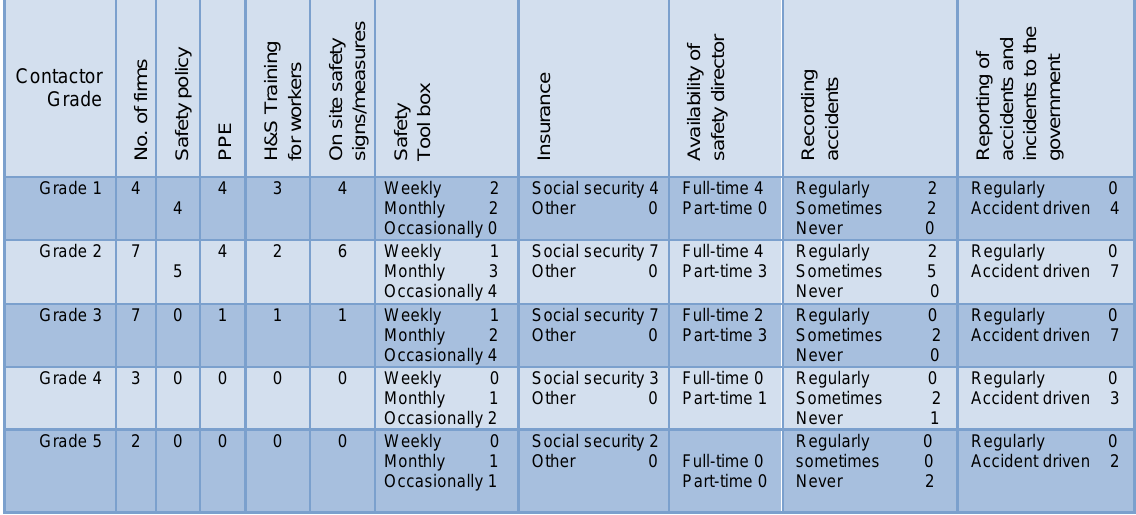
Table 1 Contractors’ interview